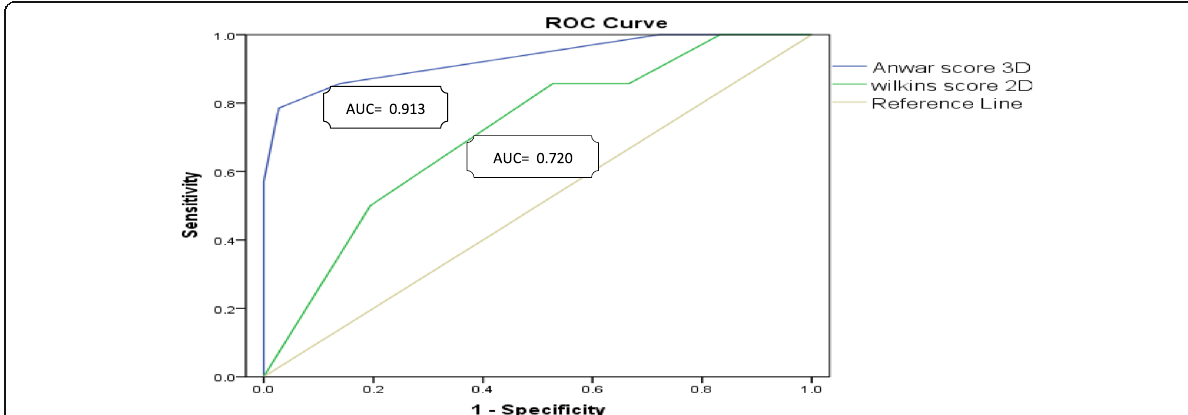
Fig. 4 Roc curve analysis for 3D-Anwar score and 2D-Wilkins score in predicting the occurrence of suboptimal results after percutaneous balloon mitral